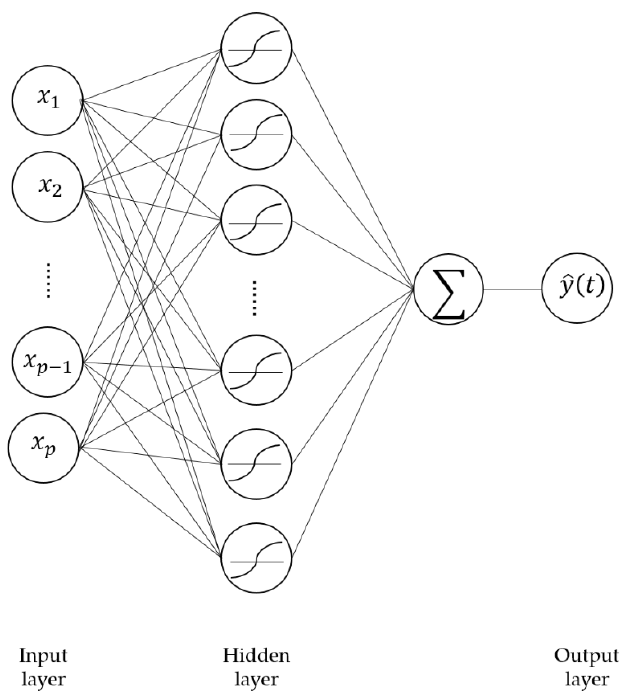
Figure 2. Graphical representation of the typical three-layer backpropagation neural network.